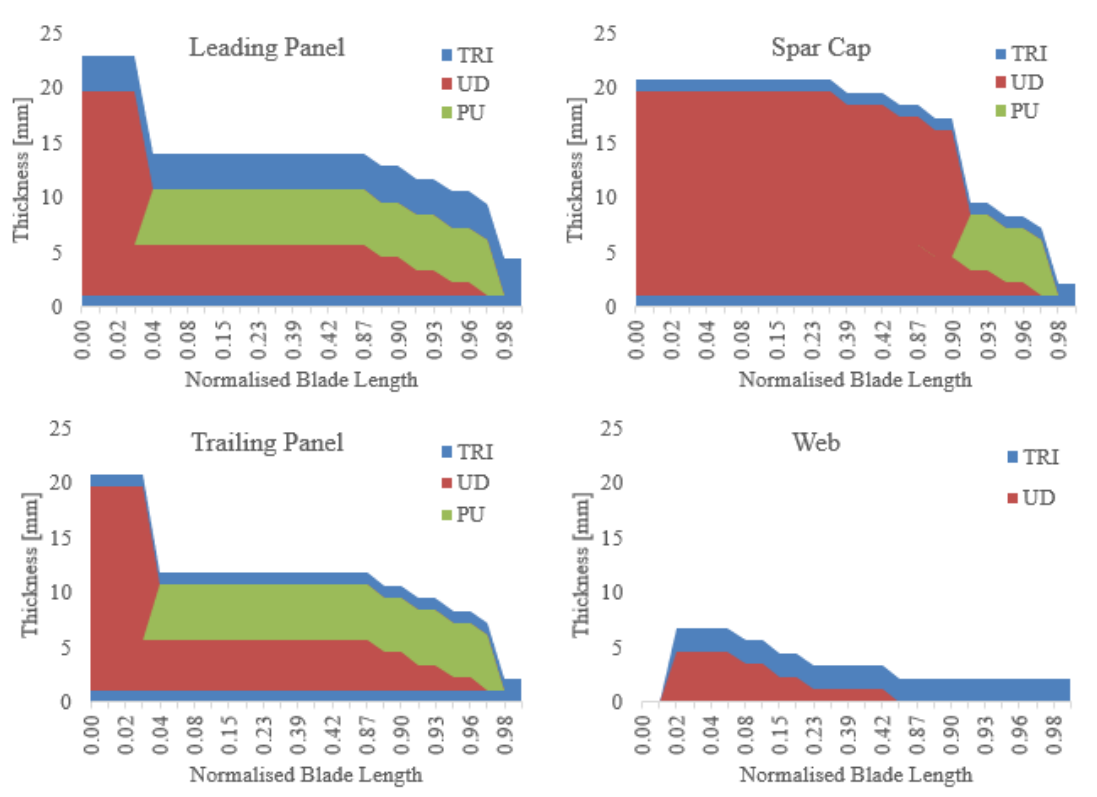
Figure 6. Orientation of the installed wind turbine blade during the static testing campaign. The output from this instrumentation has been recorded by a National Instruments (NI) PXI data acquisition system and then processed in order to determine the results from the testing, which are used in the comparison in Section 5.